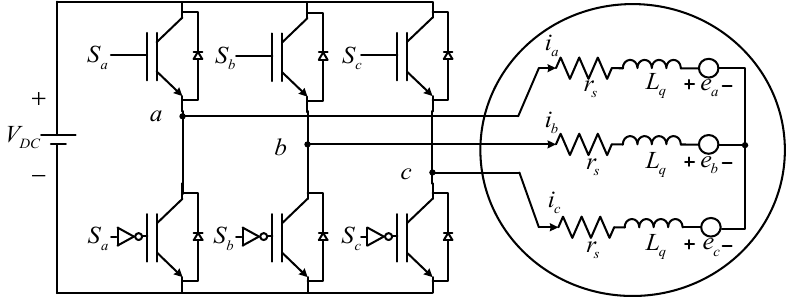
Figure 1. Diagram of three-phase six-switch voltage source inverter-fed IPMSM.